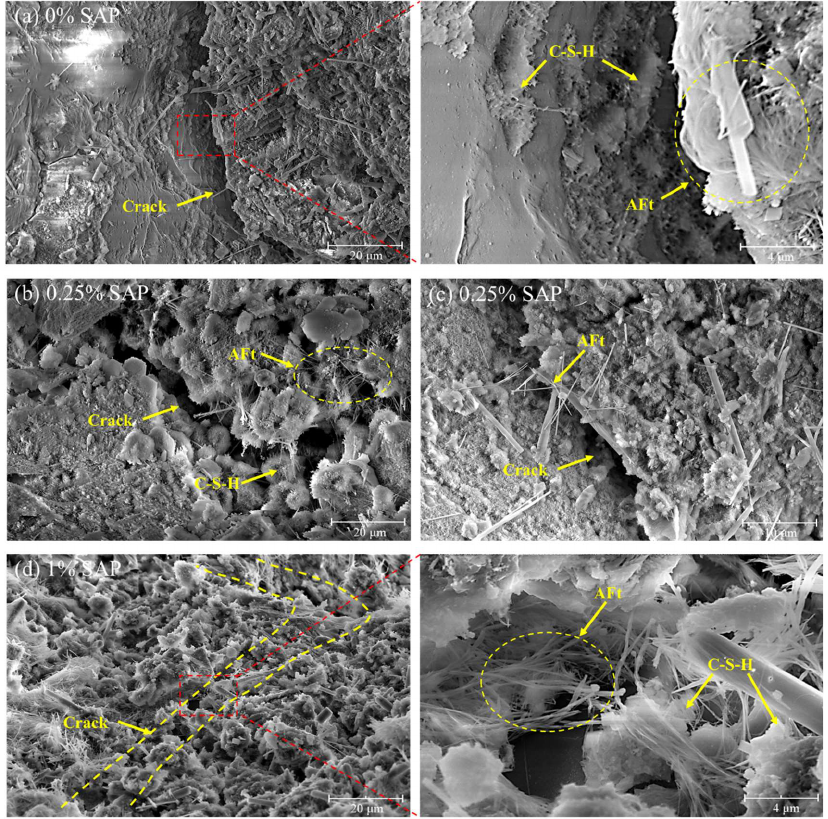
Figure 10. Micromorphology and microstructure of the samples with a W/C ratio of 0.35 at 28 d: ( a ) 0% SAP, ( b , c ) 0.25% SAP, and ( d ) 1% SAP.